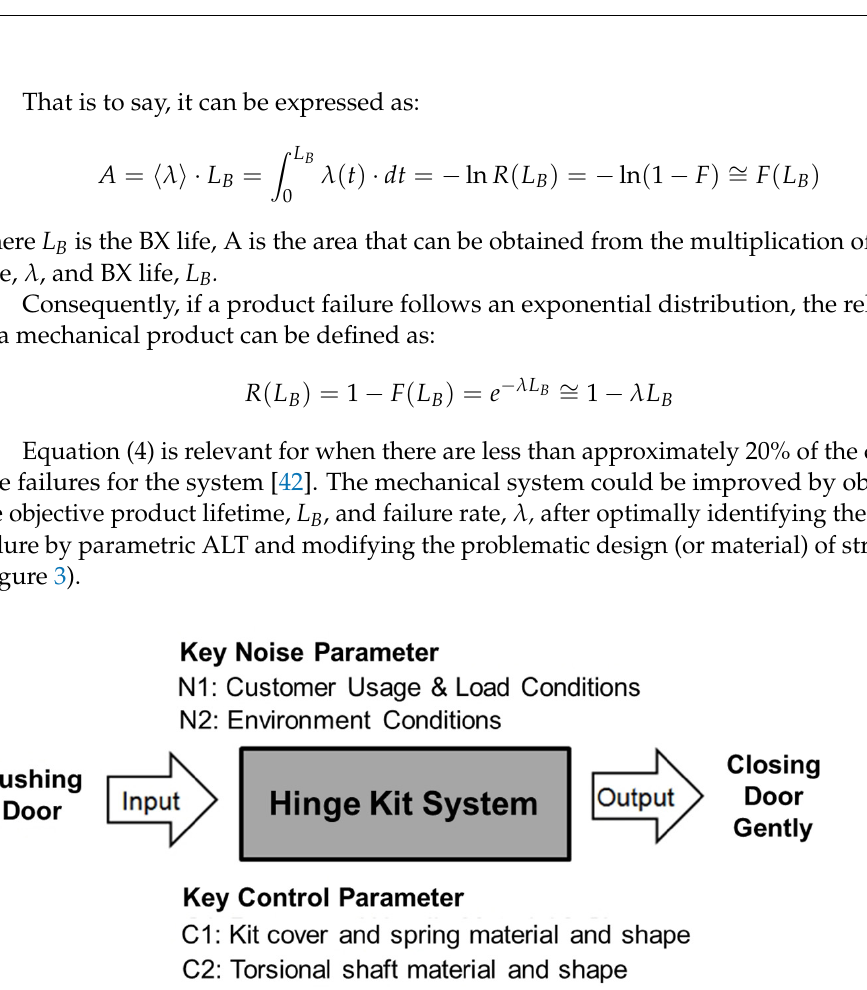
Table 1. Whole ALT plan of mechanical system such as modules in a refrigerator.